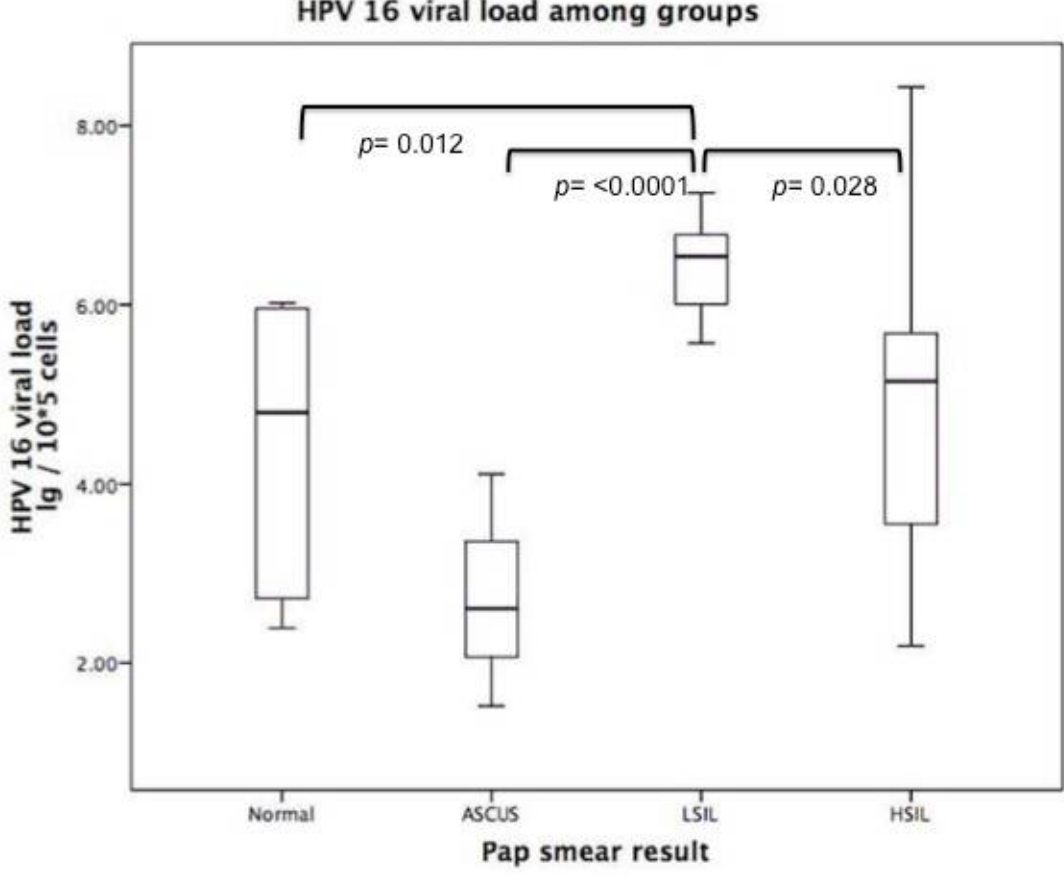
Figure 2. HPV 16 viral load at first consultation. In patients with low-grade squamous intraepithelial lesions (LSIL), a high viral load was found. The most heterogeneous group was that of patients with high-grade squamous intraepithelial lesions (HSIL).